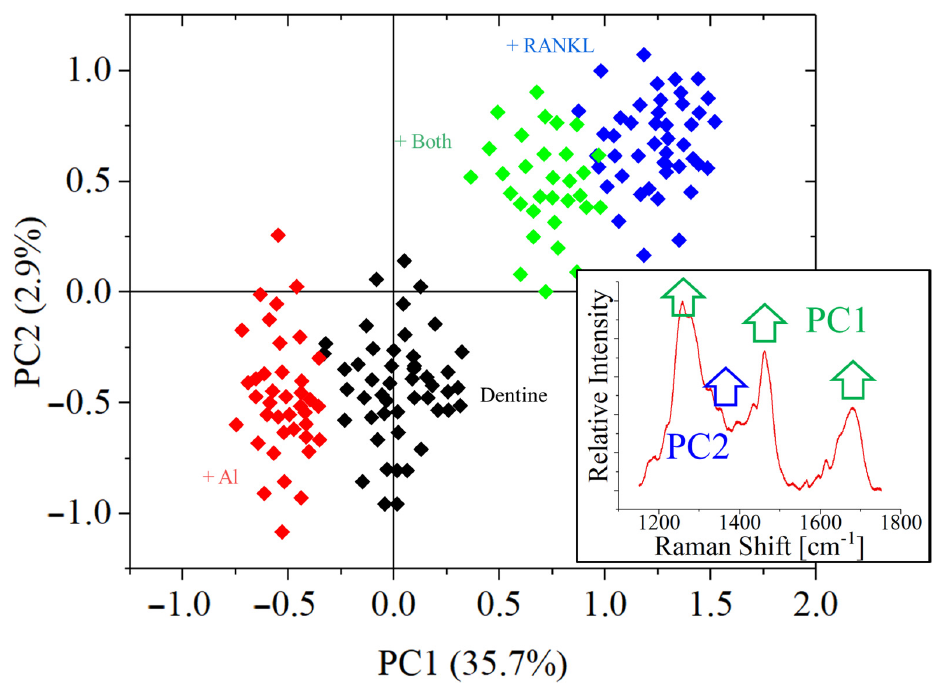
Figure 12. PCA analysis for the amide region of the dentine samples, PC1 related to the bandwidth of the 960 cm − 1 phosphate vibration and PC2 related to the intensity of the phenylalanine band at about 1004 cm − 1 .